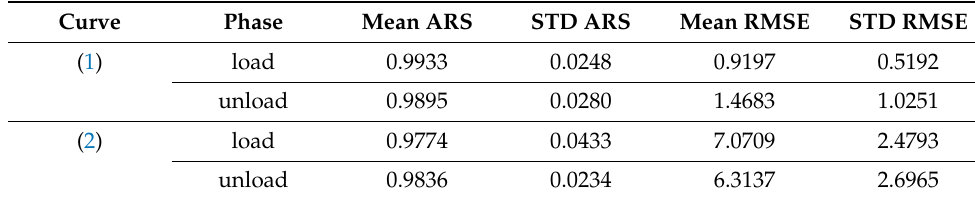
Table 1. Goodness of fit statistic summary.